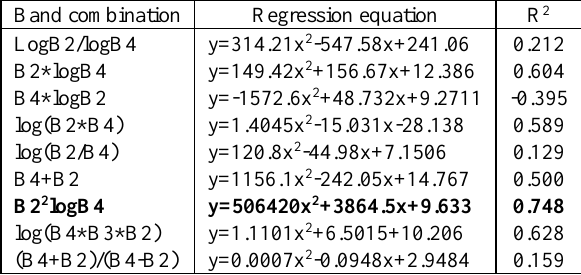
Table 2. Regression equations and R 2 values for various band combinations, where, B4=Red Band, B3=Green Band, B2=Blue